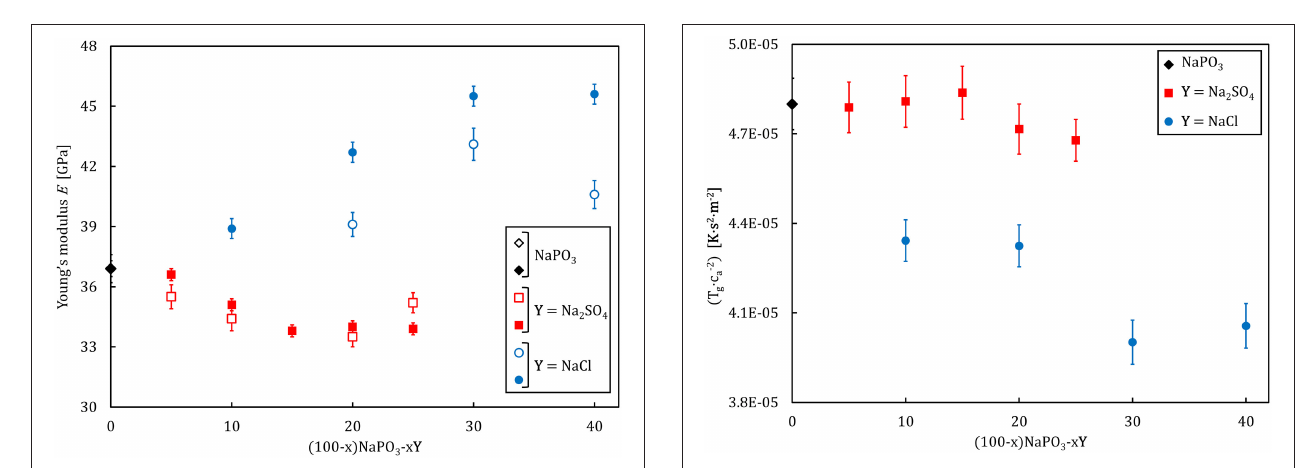
FIGURE 4 | Young’s modulus, as determined by ultrasonic echography (empty symbols) and nanoindentation (filled symbols), respectively, as a function of composition for (100–x)NaPO 3 -x Y (with Y = Na 2 SO 4 , NaCl) glasses.